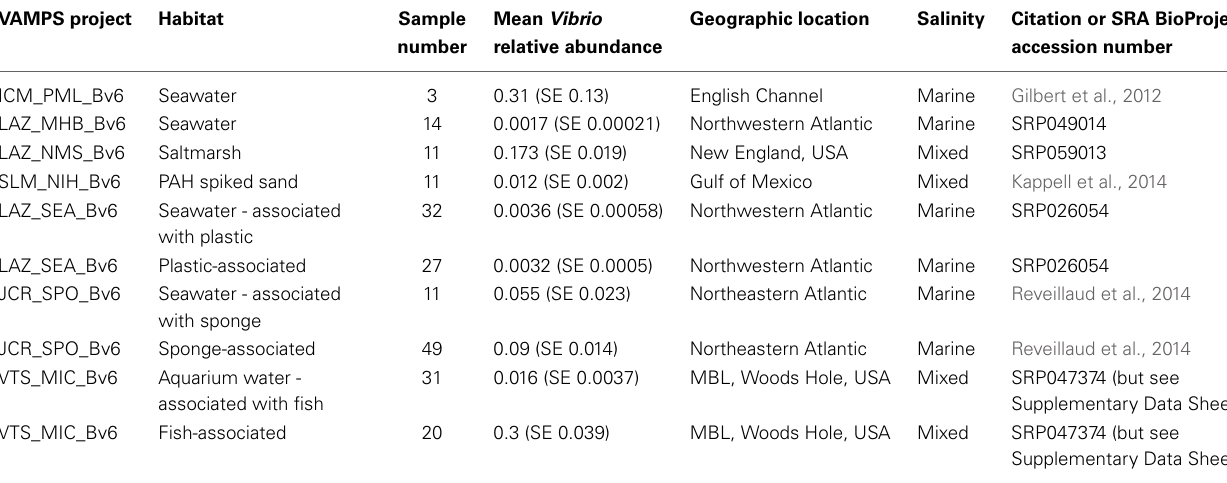
Table 1 | Overview of projects used from the VAMPS database with their original citation. VAMPS